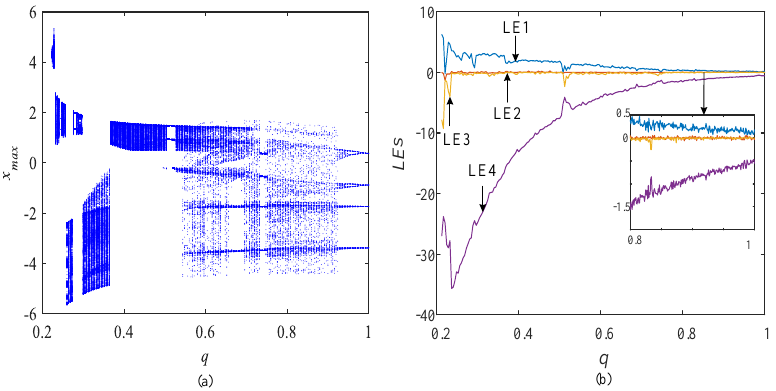
Figure 3. Dynamics with q change: ( a ) bifurcation diagram, ( b ) Lyapunov